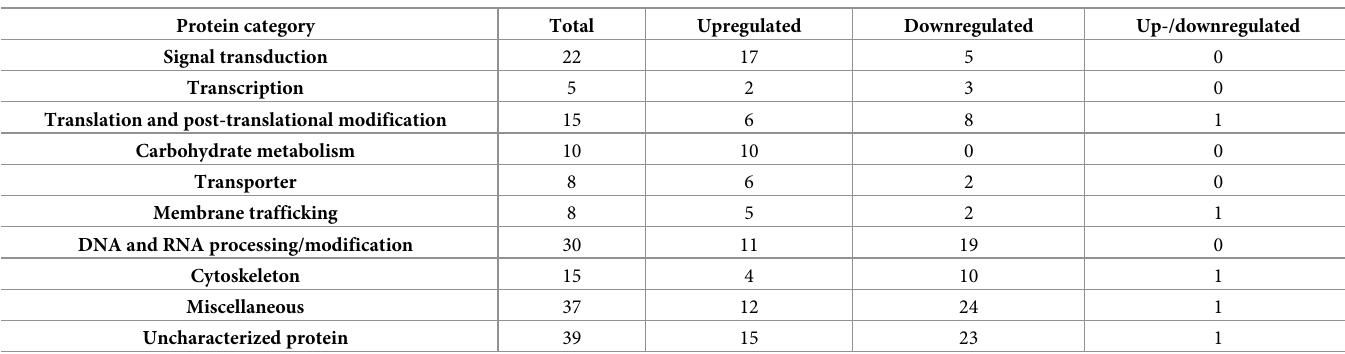
Table 1. Summary of the phosphoproteins affected by Al 3+ . Protein